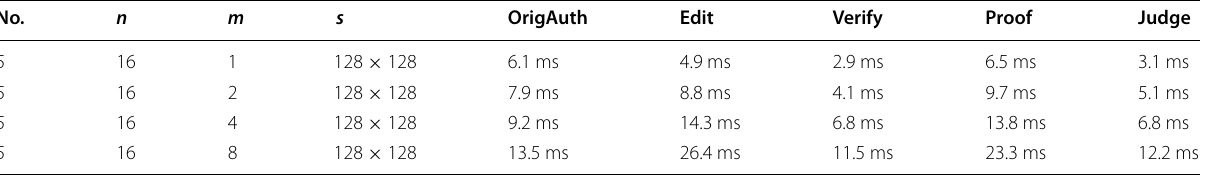
n : the number of areas, m : the number of edited areas, s : the size of the areas